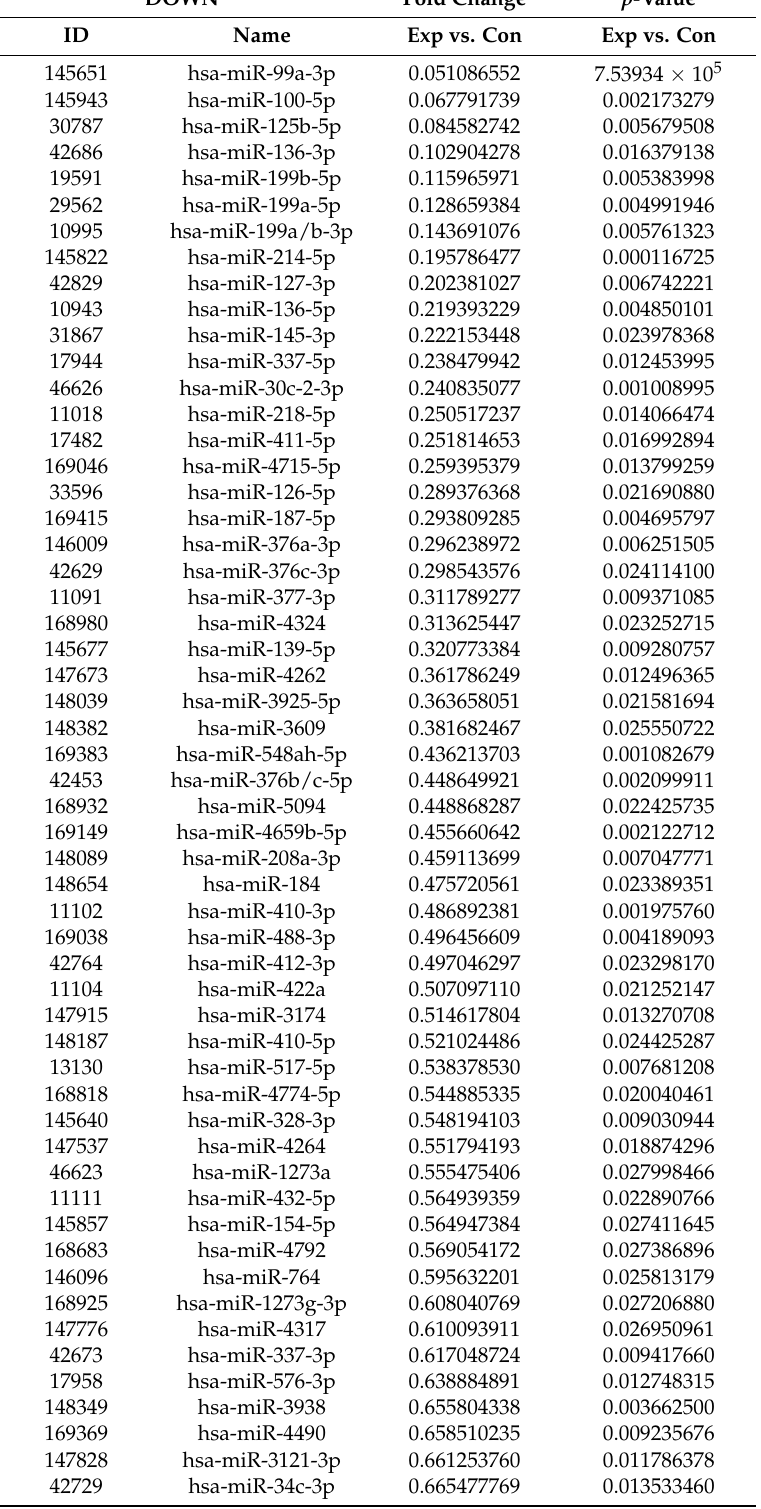
Table 2. The 81 down-regulated miRNAs ranked by fold changes in microarray data. DOWN Fold Change p